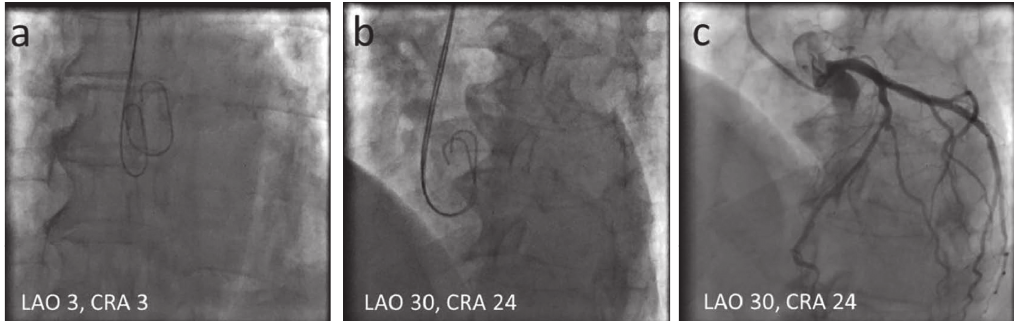
Figure 1: Optimal projection to visualize the LMCA ostium determined by fluoroscopic images of the wires. LAO � left anterior oblique; CRA � cranial.